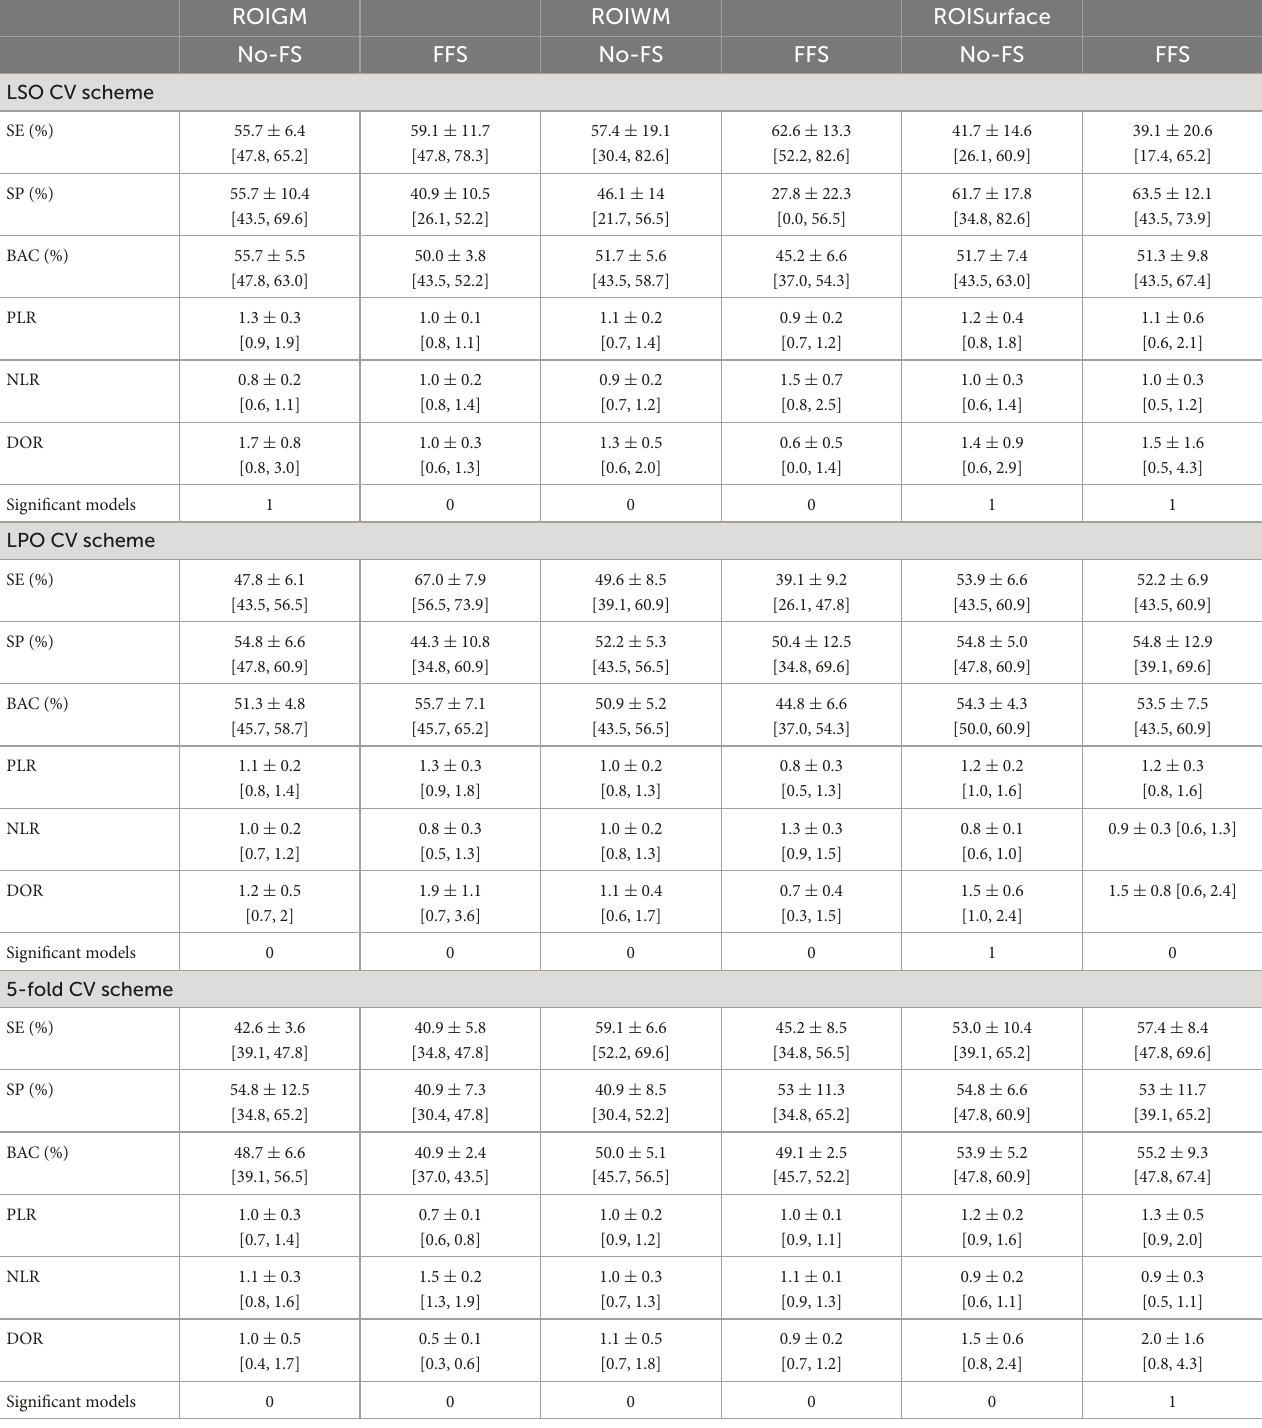
Measures for each tested combination of brain regional feature type [i.e., regional-based gray (ROIGM) and white (ROIWM) matter volume; and surface-based regional cortical thickness, gyrification,sulci,andcomplexityindexes(ROISurface)],featureselection[i.e.,nofeatureselection(No-FS);andforwardfeatureselection(FFS)],andcross-validation(CV)scheme[i.e.,leave-one scan acquisition protocol-out (LSO) CV; leave-one per group-out (LPO) CV; and 5-fold CV] are presented. Statistical significance of the balanced accuracy (BAC) for each bootstrapped sample was tested using permutation testing with a significance level of 5%. Data format: mean ± standard deviation [min max]. DOR, diagnostic odds ratio; NLR, negative likelihood ratio; PLR,